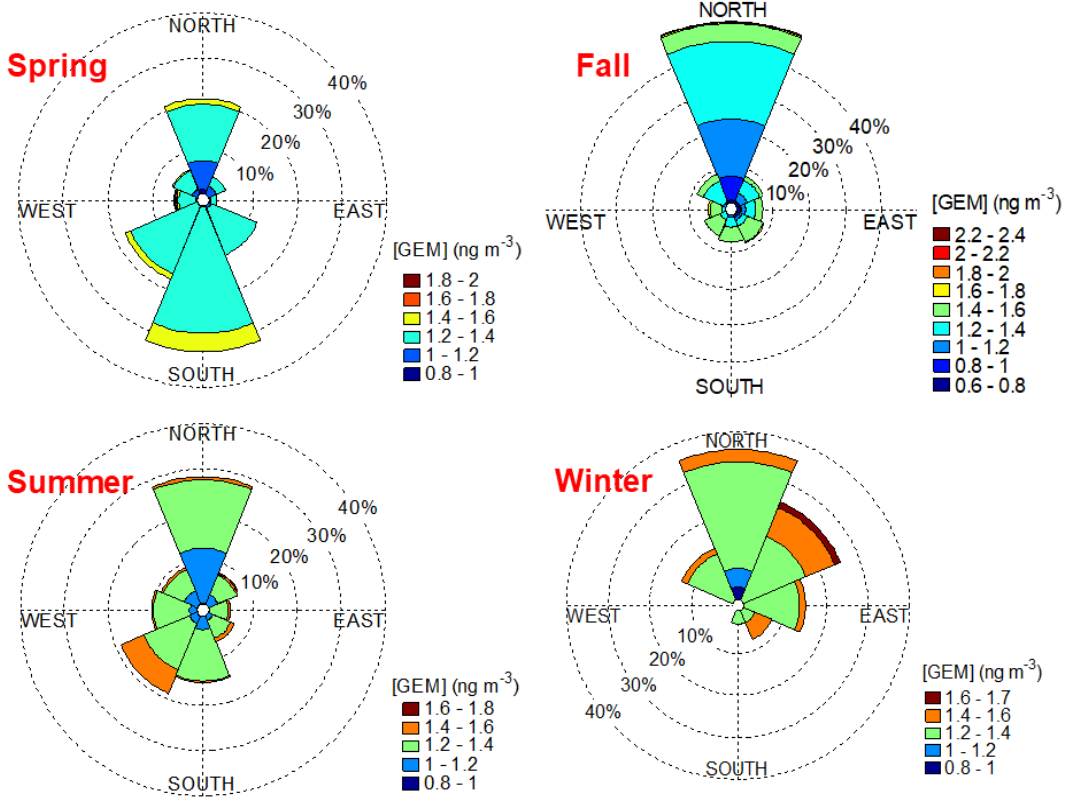
Figure 4. Wind roses showing the relationship between GEM levels and wind direction for each sampling period at Grand Bay.